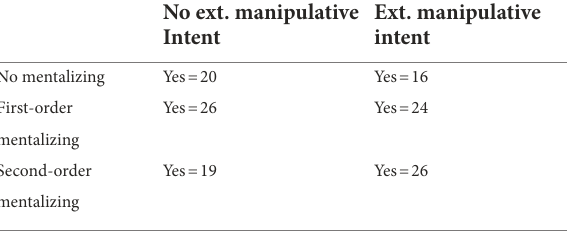
TABLE 4 Distribution of yes responses referring to the question if participants want help from the robot. “Would you like to give 10 points to get tips from robot